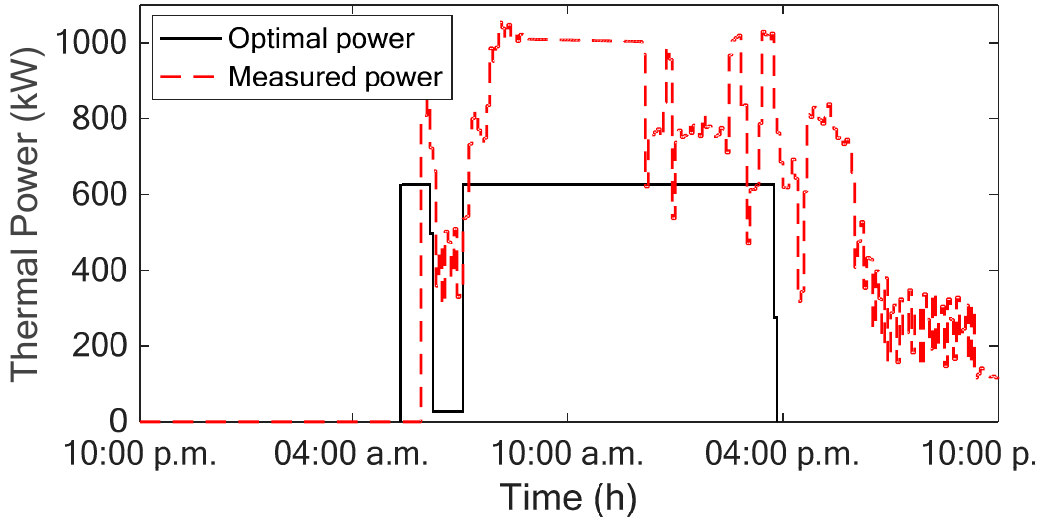
Figure 10. Power daily profile: optimal profile versus real profile.